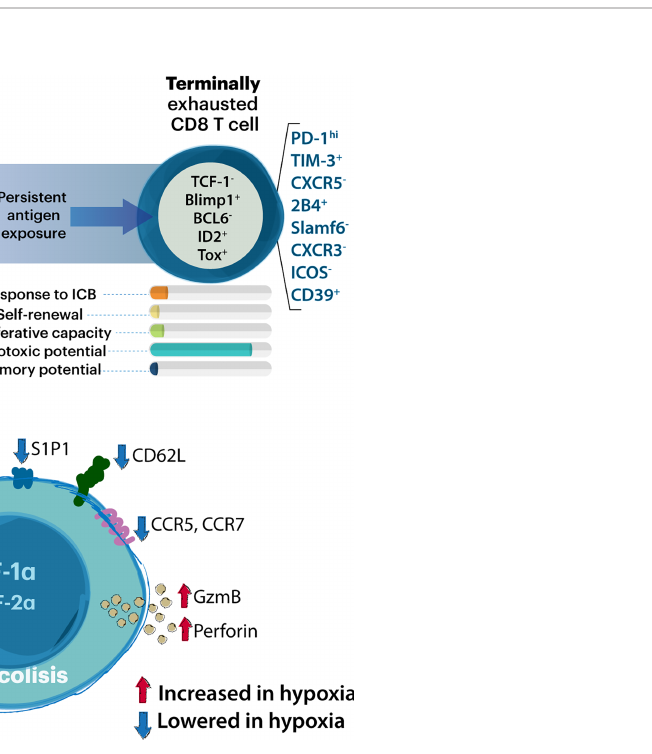
FIGURE 1 | Association between CD8 T cell exhaustion and hypoxia. (A) Schematic representation of progenitor and terminally exhausted T cell subsets. Although T cell exhaustion comprises a wide range of exhausted states, two major subsets of exhCD8 T cells have been studied in detail: the progenitor and the terminally exhausted T cell population. Whereas progenitor exhausted T cells exhibit proliferative potential, and stemness properties and can be rescued by immune checkpoint blockade (ICB) therapies, terminally exhausted T cells have higher cytotoxic potential but represent a terminal differentiation state and cannot be rescued by ICB. Proposed key molecules which discriminate these subpopulations are listed. (B) Modulation of CD8 T cell functions by hypoxia. Through HIF-1 a and HIF2 a - dependent mechanisms, hypoxic stimuli favor glycolytic anaerobic metabolism promoting T cell receptor (TCR) signaling. These include enhanced perforin and granzyme-B (GzmB) release as well as expression of immune checkpoint molecules (including both activators and inhibitors). Hypoxia inhibits expression of chemokine and cytokine receptors and adhesion